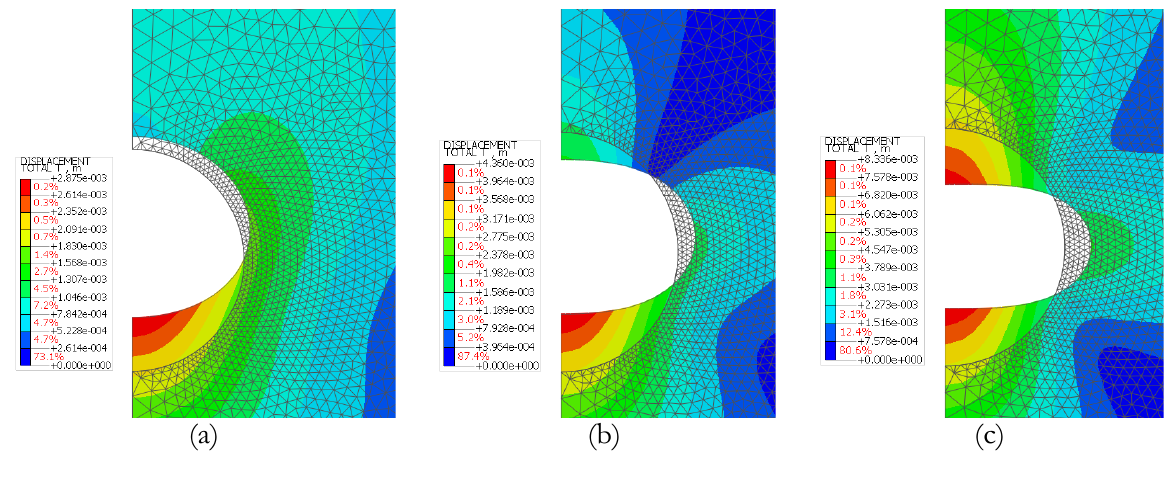
Figure 8. Variation of displacements in calculation stage (E3) (lined displacements) for scenarios varying cover in material with lower stiffness. (a) low cover; (b) medium cover; (c) high